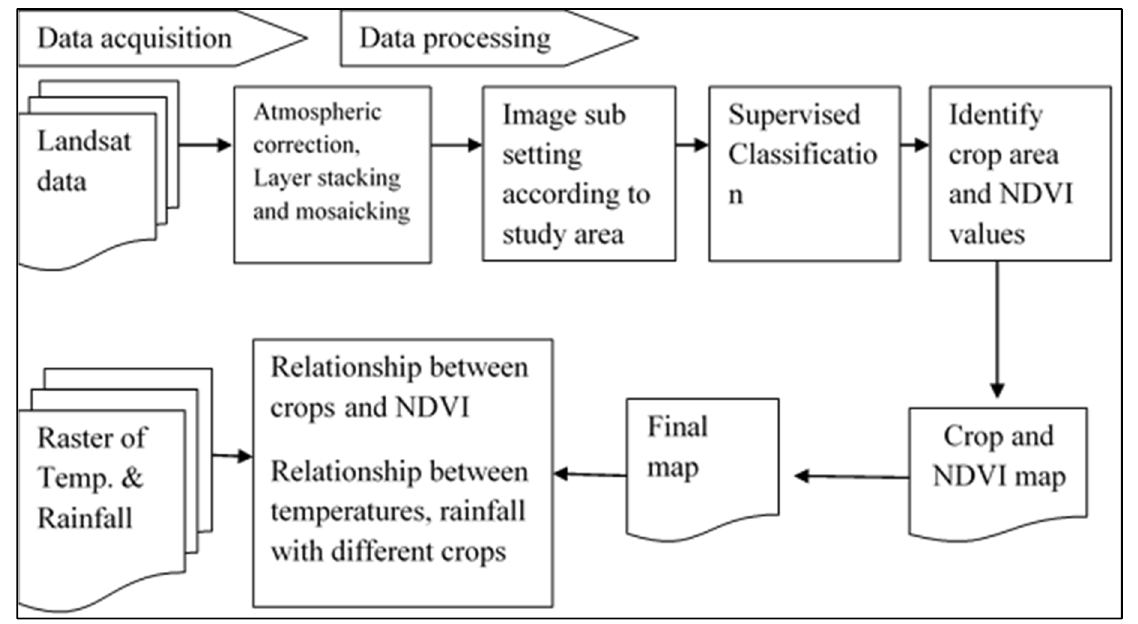
Figure 3. Flow chart for the